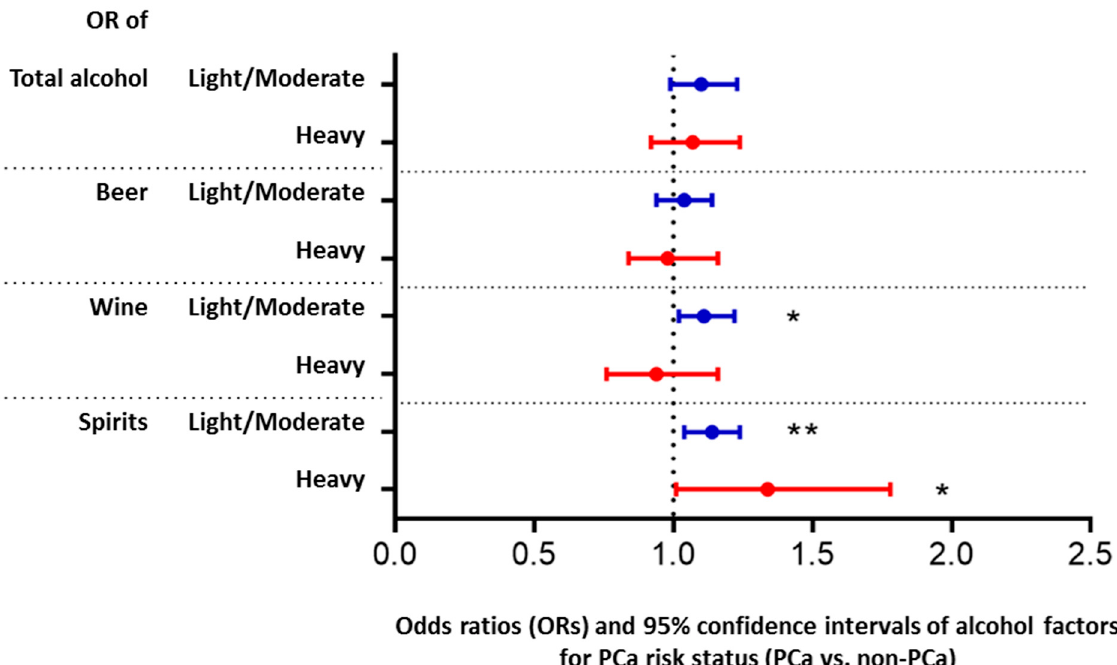
Figure 1. Impact of prostate cancer (PCa) risk status on intake of total alcohol and specific alcoholic beverage types. The results are based on multinomial logistic model with an alcohol factor (three sub-groups: infrequent, light/moderate, and heavy intake) as the outcome. Factors in the model were PCa risk status (PCa/ non-PCa), age, BMI, smoking, and region. Odds ratio (OR) and 95% confidence interval of light/moderate (vs. infrequent intake) and heavy (vs. infrequent intake) for PCa vs. non-PCa were shown. *: p < 0.05, **: p < 0.01. The association of PCa risk status (PCa vs. non-PCa) with alcohol intake without adjusting other factors is shown in Table 1. PCa risk status was significantly associated with intake of total alcohol and three alcoholic beverage types ( p < 0.001). Prevalence of heavy intake of total alcohol was significantly different for non-PCa men, patients with non-aggressive PCa, and patients with aggressive PCa (Tables 1 and 2, 12.9%, 14.9%, and 18.7%, respectively; p < 0.001). PCa patients had higher prevalence of current heavy alcohol in- take than non-PCa subjects (15.5% vs. 12.9%, crude OR of heavy intake = 1.71, p < 0.001). For beer intake, PCa patients had significantly higher prevalence of current light/moder- ate (58.6% vs. 52.4%, crude OR = 1.39, p < 0.001) and heavy beer intake (9.6% vs. 8.0%, crude OR = 1.50, p < 0.001) compared to non-PCa men. Wine intake showed a similar pat- tern as beer intake for PCa patients, but PCa patients were not significantly associated with heavy spirits intake ( p = 0.614). PCa patients had higher prevalence of current light/moderate spirits intake (44.6% vs. 38.9%, crude OR = 1.27, p < 0.001), but had the same heavy spirit intake prevalence (2.2% vs. 2.2%) compared with the non-PCa men.